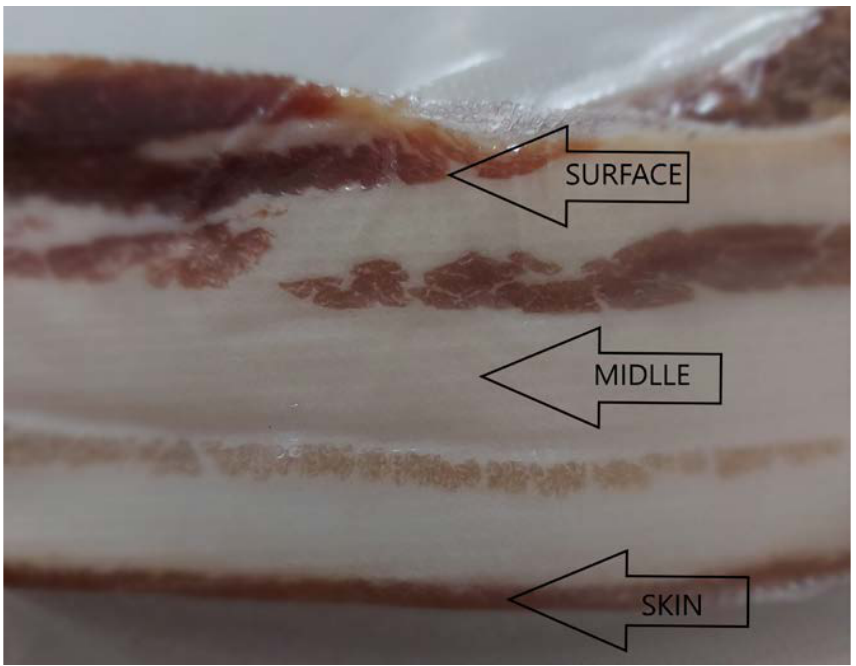
Figure 1. Dry cured smoked bacon Slavonska slanina (cross section) with sampling positions for PAH determination.